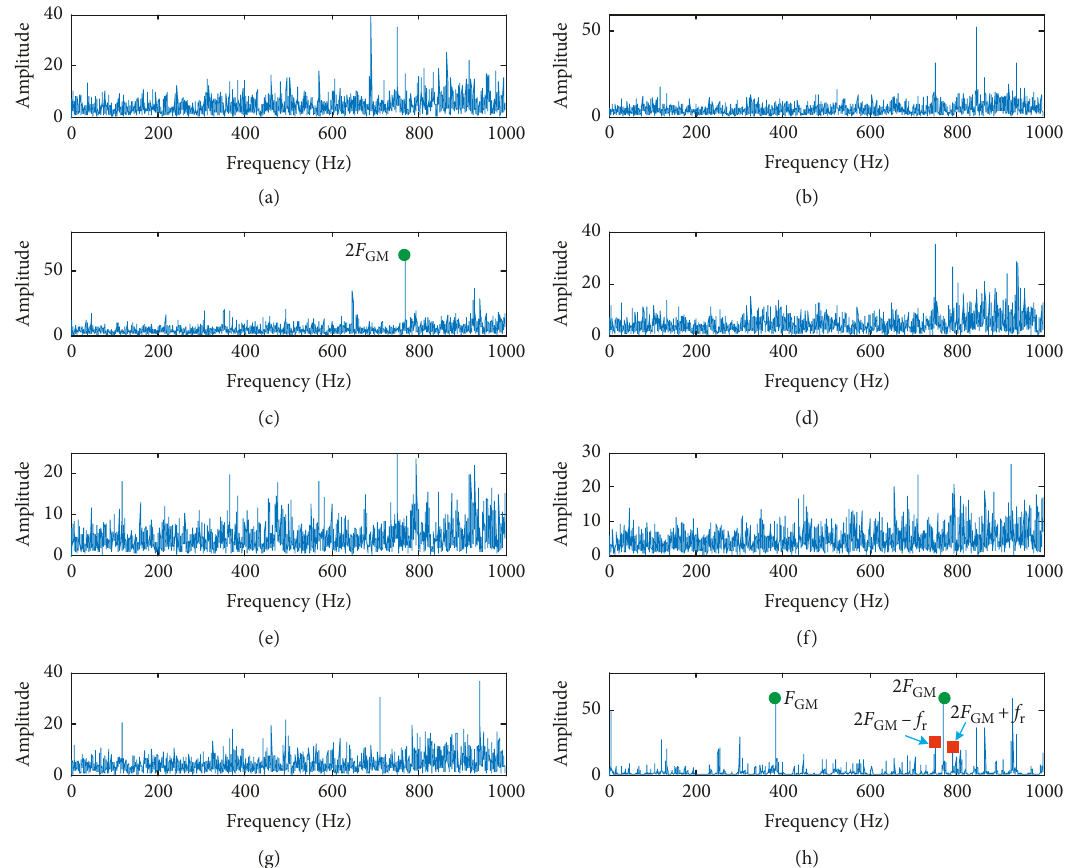
Figure 32: The frequency domain diagram of multiresolution DMD modes of the broken teeth fault signal, where (a)–(h) are corresponding to signals of Figure 28,